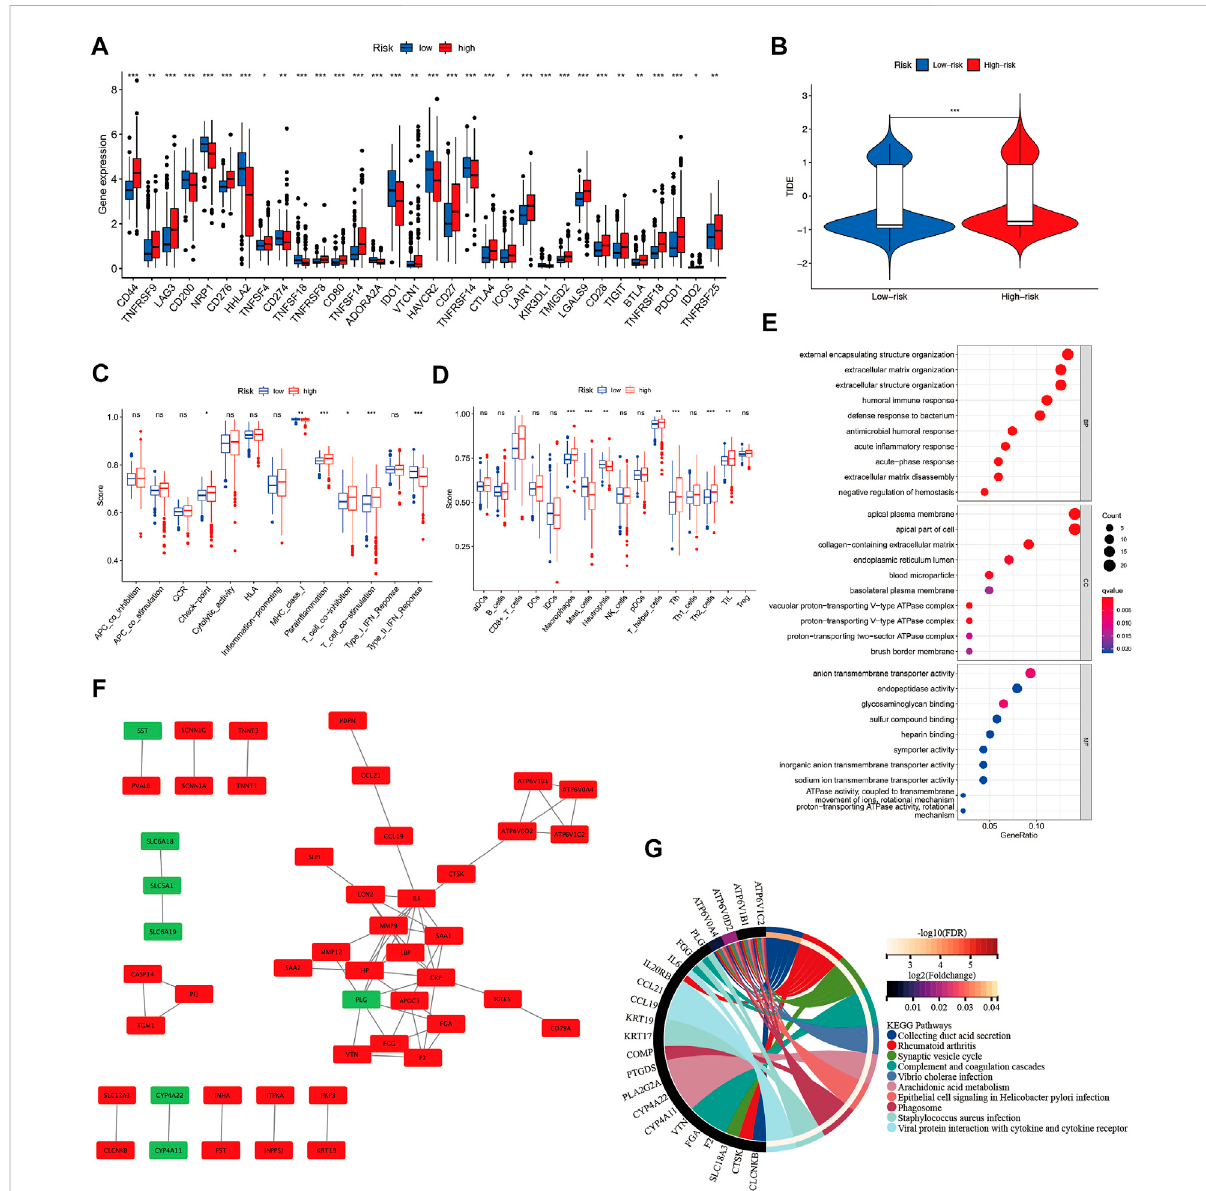
FIGURE 4 (A) Differences in immune checkpoint gene expression between SAGRI subgroups; (B) Differences in TIDE scores between SAGRI subgroups; (C,D) Differences in immune cells and immune function between SAGRI subgroups; (E) Results of GO enrichment analysis between SAGRI subgroups; (F) Differential gene-protein interactions between SAGRI subgroups; (G) Results of KEGG enrichment analysis between SAGRI